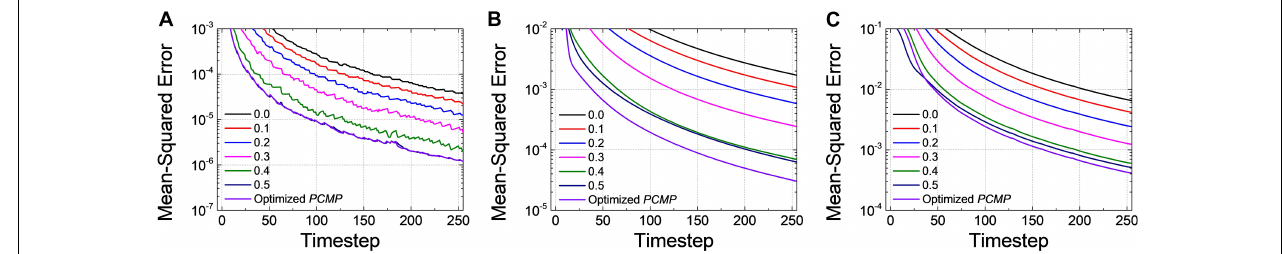
FIGURE 9 | Changes of MSE for (A) Net 1 , (B) Net 2 , and (C) Net 3 when increasing the amount of the global V pc from 0.0 to 0.5 with 0.1 steps and the optimized PCMP . Although the global PCMP is practical due to its simplicity, the layer-wise optimization is more effective in a fast decrease of MSE .